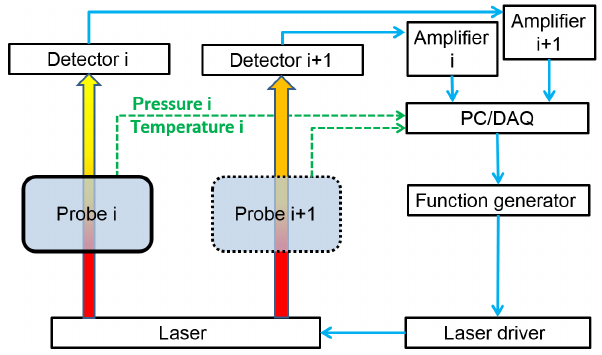
Figure 1. Simplified schematic of a standard dTDLAS setup with several spectroscopic channels: HAI combines two lasers (one at 1.4µm for high, one at 2.6µm for low water vapor concentra- tions), with two locations cells (1 × open-path and 2 × closed-path), and supplementary spectroscopic channels (parasitic water detector (Buchholz and Ebert, 2014b) and reference cell for spectral stabi- lization). HAI has in total seven spectroscopic channels.